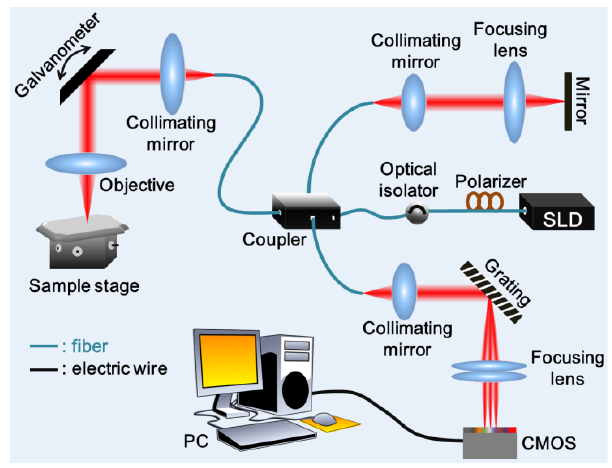
Fig. 2. Schematic diagram of the SD-OCT system.